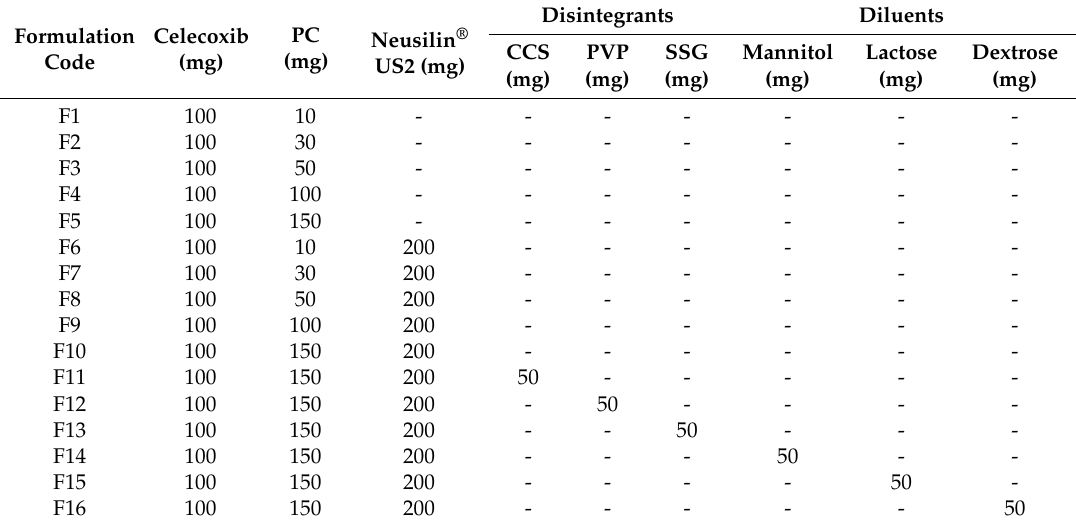
Table 1. Compositions of phosphatidylcholine (PC)-based dispersion formulations for celecoxib (CLC).